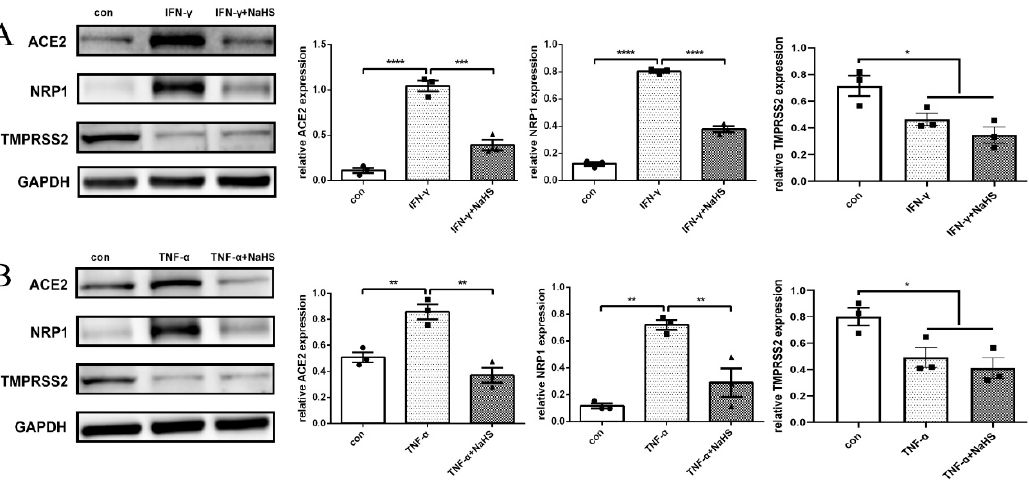
Figure 4. The effect of H 2 S on SARS-CoV-2 infection-promoting molecules in normal human primary thyrocytes. ( A ) ACE2, NRP1 and TMPRSS2 protein expression in normal human primary thyrocytes treated with 50 ng/mL IFN- γ or 100 µ M NaHS plus IFN- γ was assessed by Western blot. ACE2 and NRP1 protein levels were upregulated by IFN- γ , and this effect was reversed by NaHS in thyrocytes. TMPRSS2 protein levels were downregulated by IFN- γ , and NaHS had no effect on TMPRSS2 protein levels. ( B ) ACE2, NRP1 and TMPRSS2 protein expression in normal human primary thyrocytes treated with 50 ng/mL TNF- α or 100 µ M NaHS plus TNF- α was assessed by Western blot. ACE2 and NRP1 protein levels were upregulated by TNF- α , and this effect was reversed by NaHS in thyrocytes. TMPRSS2 protein levels were downregulated by TNF- α , and NaHS had no influence on TMPRSS2 protein levels. * p < 0.05, ** p < 0.01, *** p < 0.001, **** p < 0.0001. ACE2: angiotensin-converting enzyme 2; NRP1: neuropilin 1; TMPRSS2: transmembrane serine protease 2; GAPDH: glyceraldehyde-3-phosphate dehydrogenase; IFN- γ : interferon- γ ; TNF- α : tumor necrosis factor- α ; NaHS: sodium hydrosulfide. The data are expressed as the mean ± SEM and were compared by one-way ANOVA among the three groups. All experiments were performed independently three